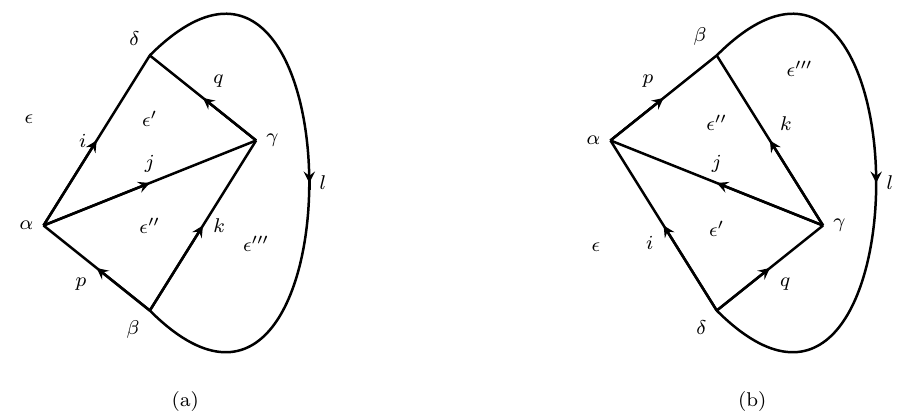
Figure 17 . The possible graphs that we attach to a